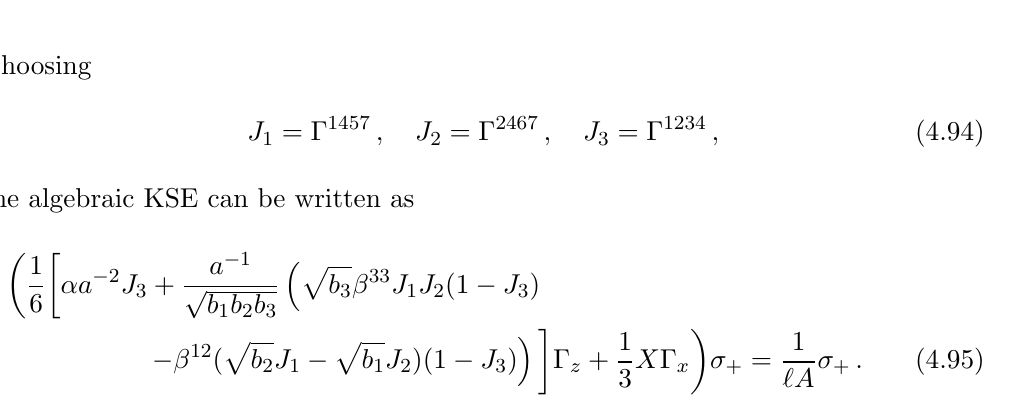
Table 11 . Decomposition of (4.95) KSE into